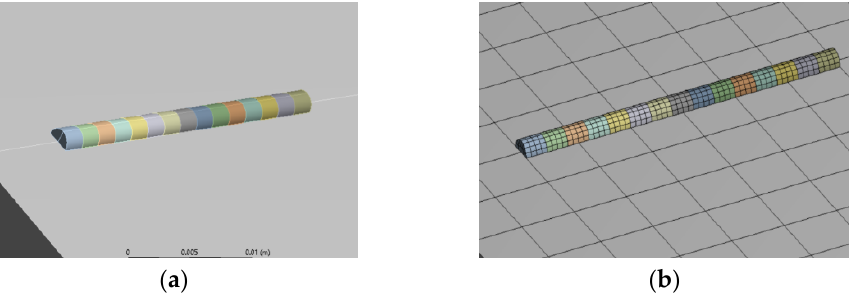
Figure 3. Geometric model and meshing. ( a ) Geometric model; ( b ) Geometric model with grids after meshing.